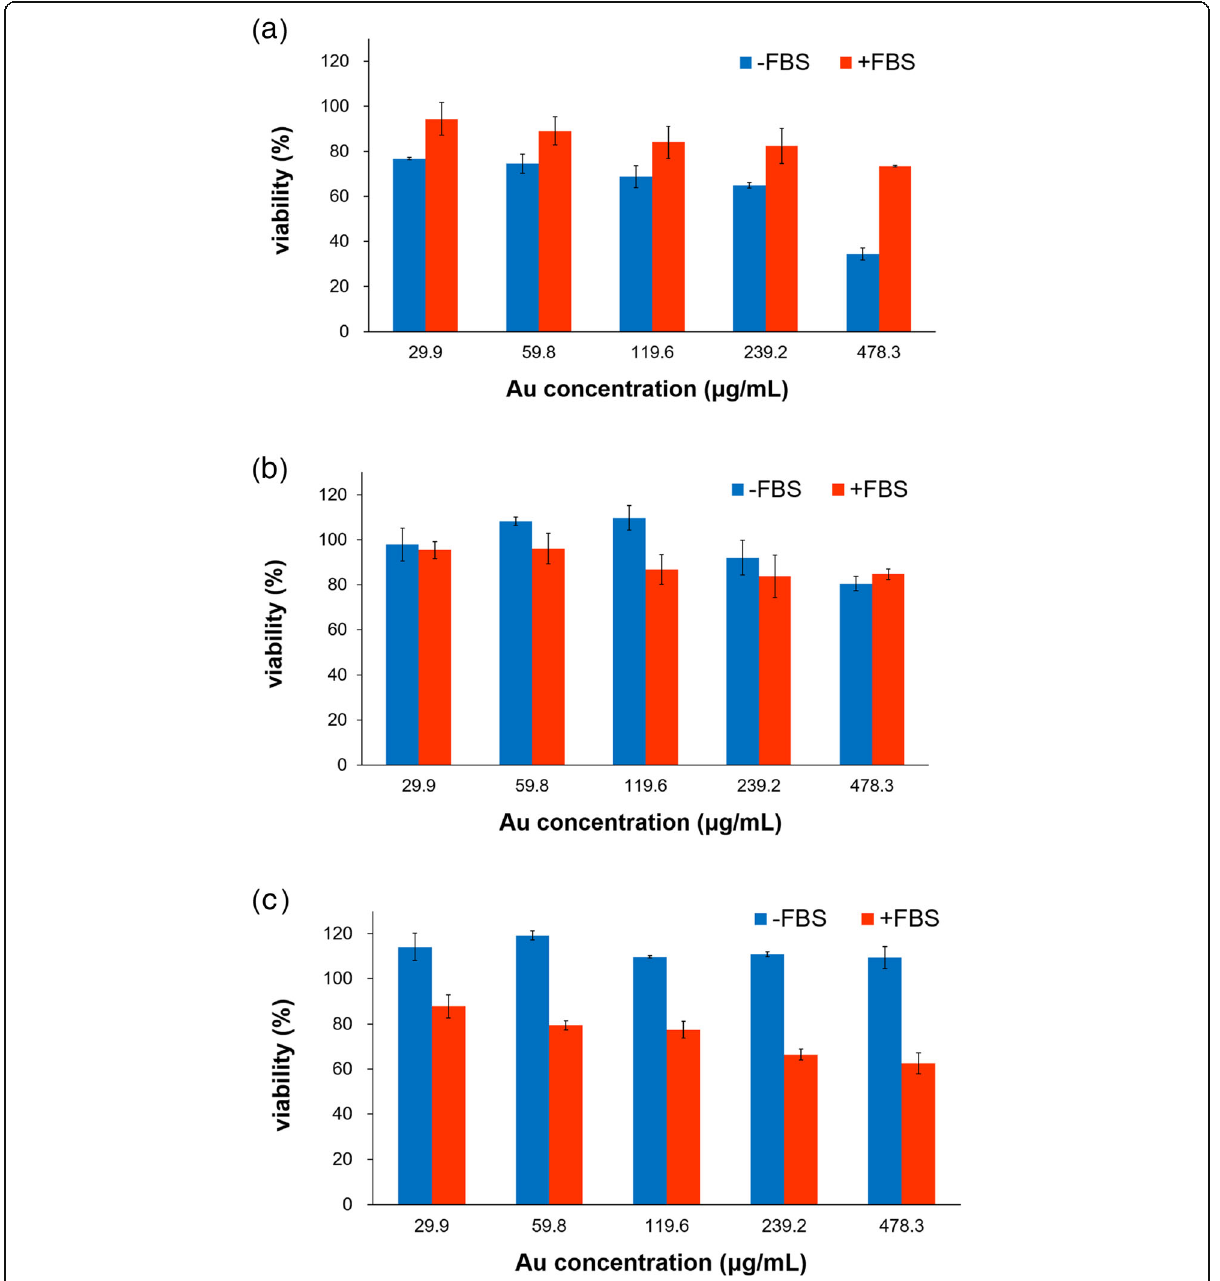
Fig. 9 In vitro cytotoxicity on cancer cells. a HT-29. b MDA-MB-231. c